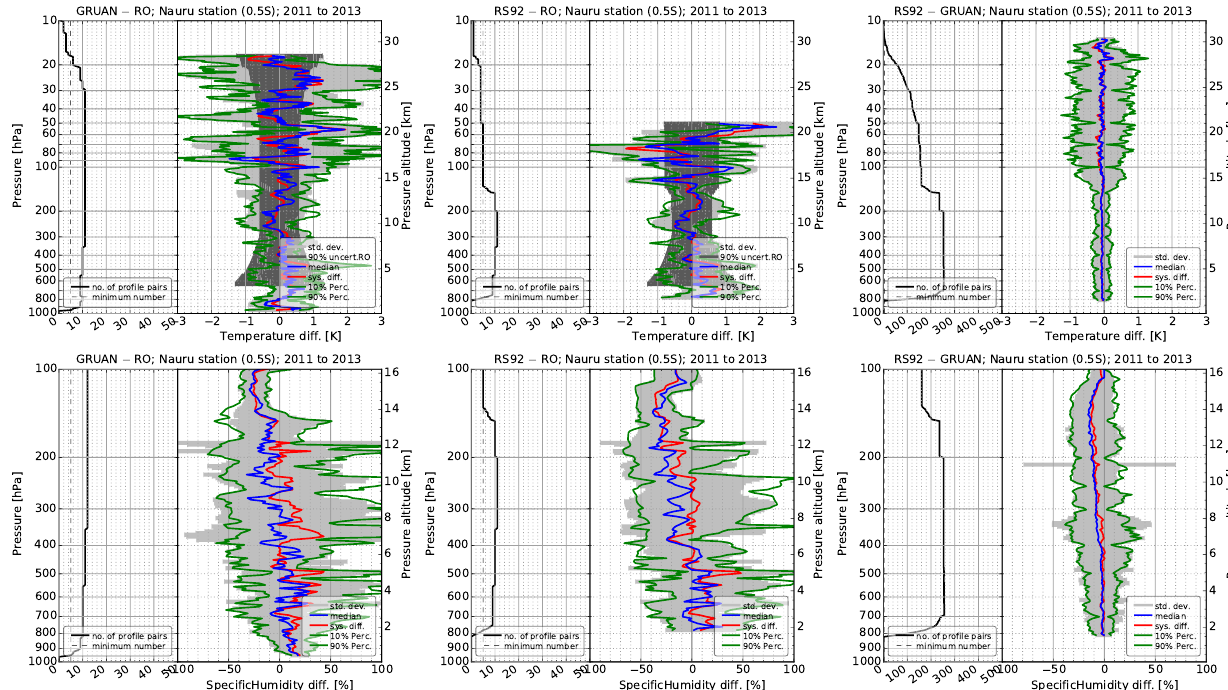
Figure 7. Comparison of temperature (top) and specific humidity (bottom) for the GRUAN station in Nauru, Southwestern Pacific. Differ- ences are shown for GRUAN versus GPSRO (left), RS92 versus GPSRO (middle), and RS92 versus GRUAN (right).